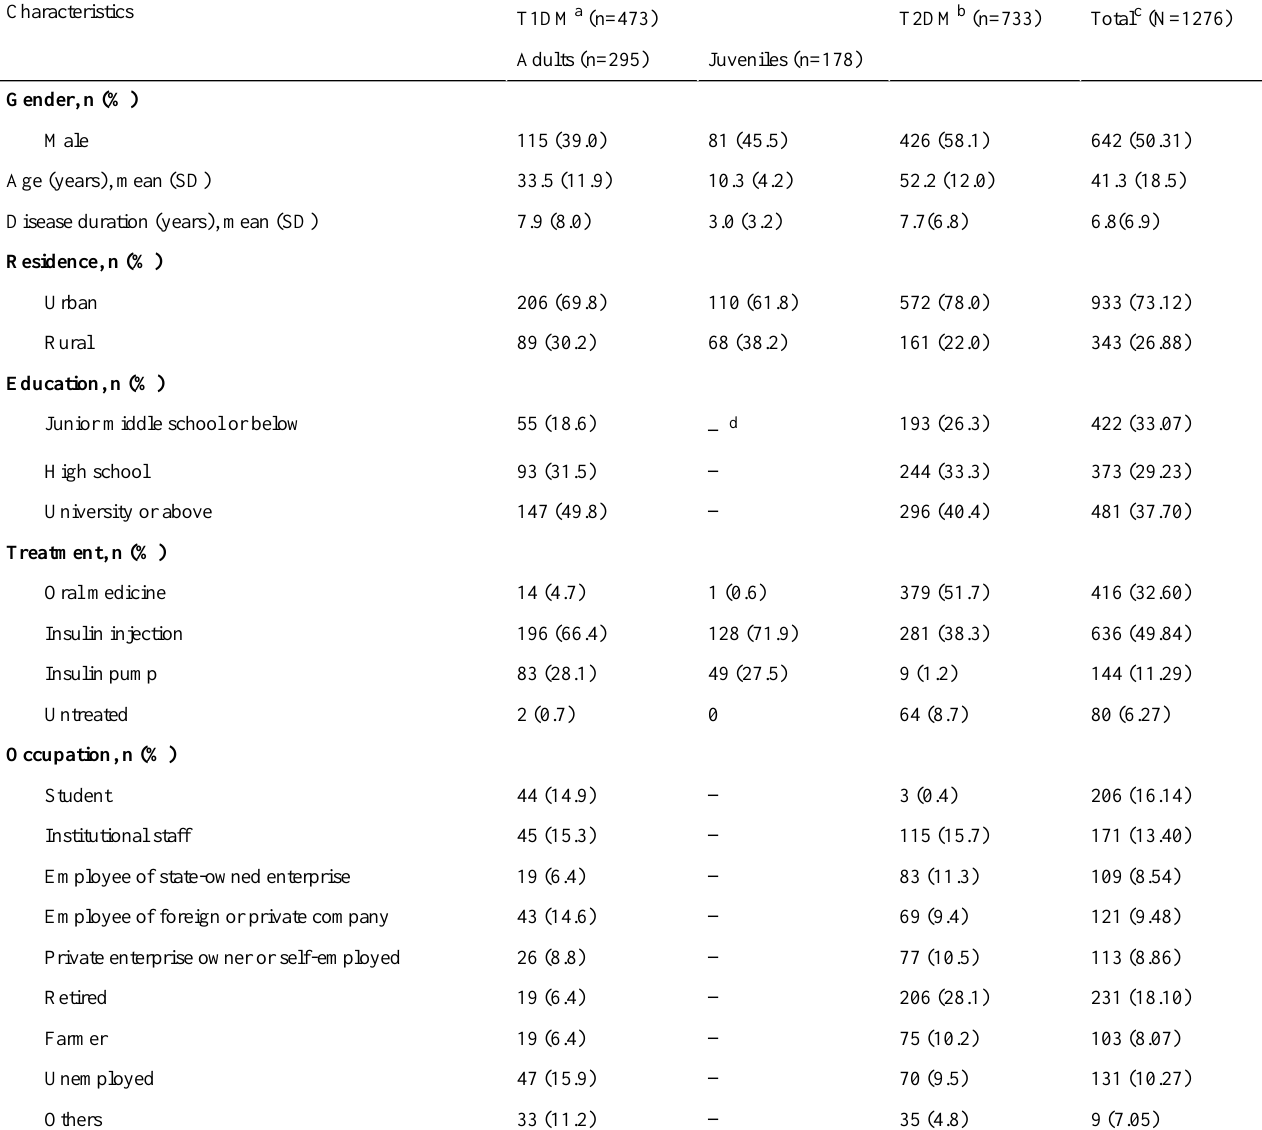
Table 1. Characteristics of patients with